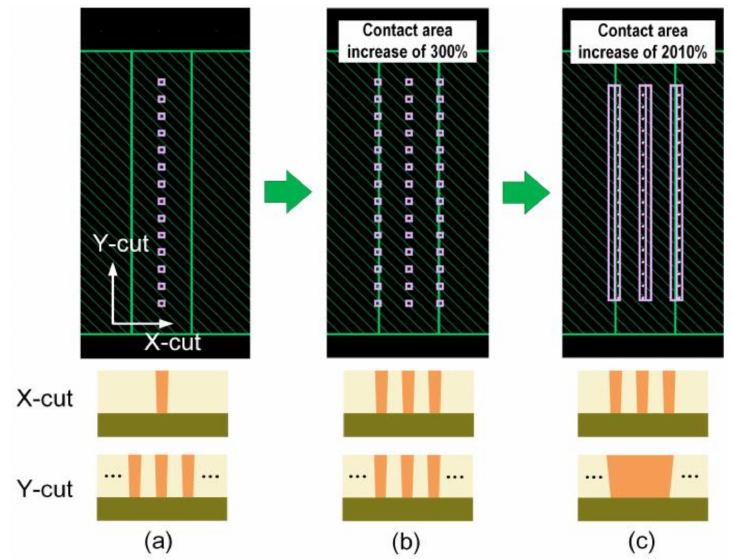
Figure 12. Contact change for dissipation improvement: ( a ) original contact count, ( b ) increased contact count ( N = 3), ( c ) novel contact strip.